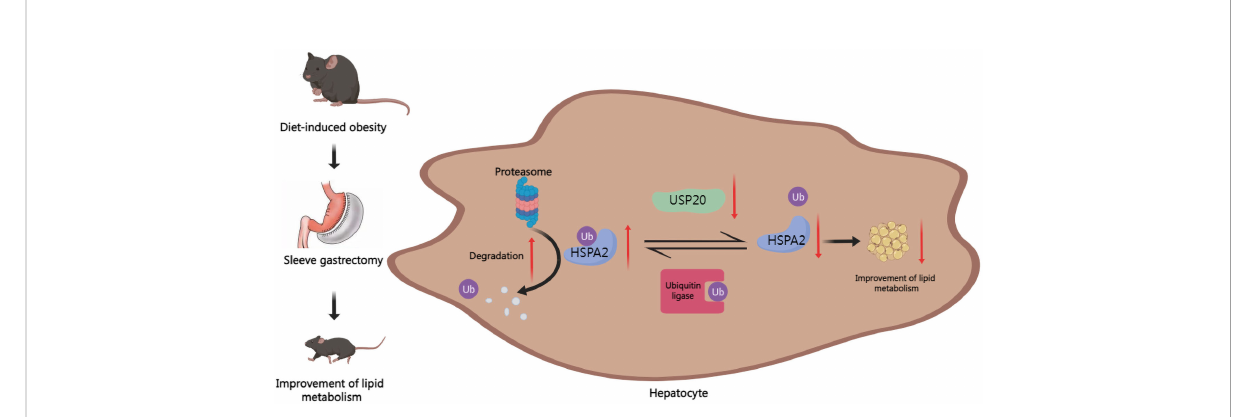
FIGURE 6 Graph of the potential mechanism of the regulatory network. SG improves lipid dysmetabolism via downregulating USP20-HSPA2 axis in DIO